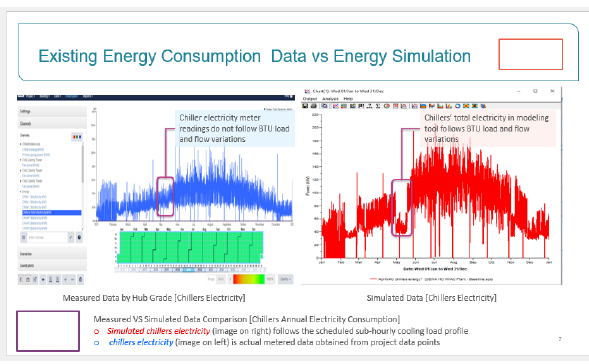
Figure 2: The simulation shows that the chillers do not modulate with varying chilled water flow and